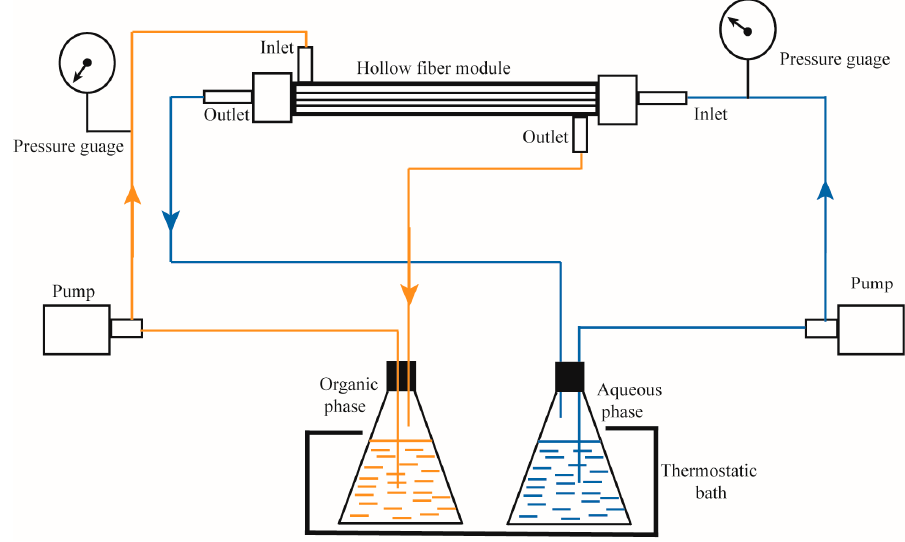
Figure 1. Hollow-fiber membrane contactors set up [15].